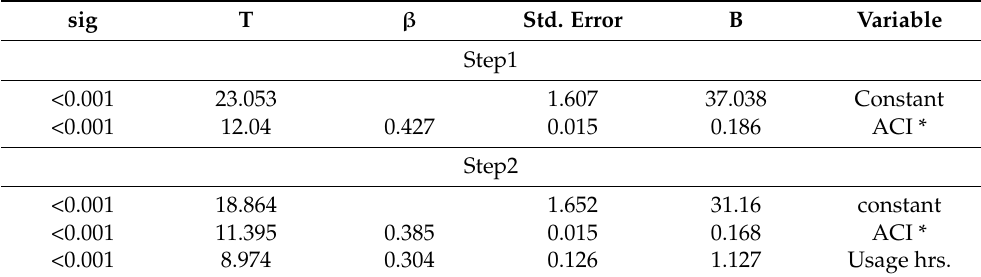
Table 6. Stepwise multiple regression for the predictive power of anxiety about COVID-19 infection, daily smartphone use hours, and age in smartphone addiction. sig T β Std. Error B Variable Step1 <0.001 23.053 1.607 37.038 Constant